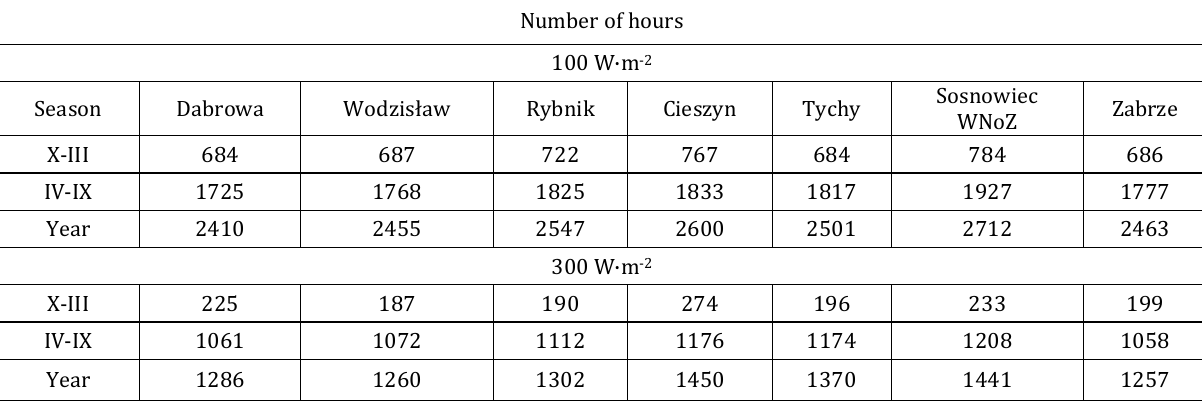
Table 3. Number of hours with global radiation exceeding the 100 W·m -2 and 300 W·m -2 threshold values in the period